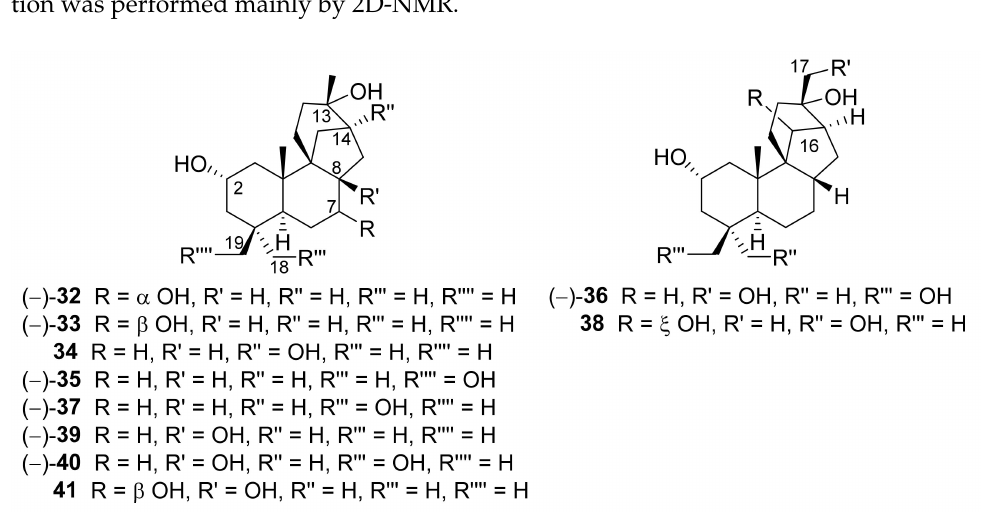
Figure 9. Stemodane diterpenoids biotransformation